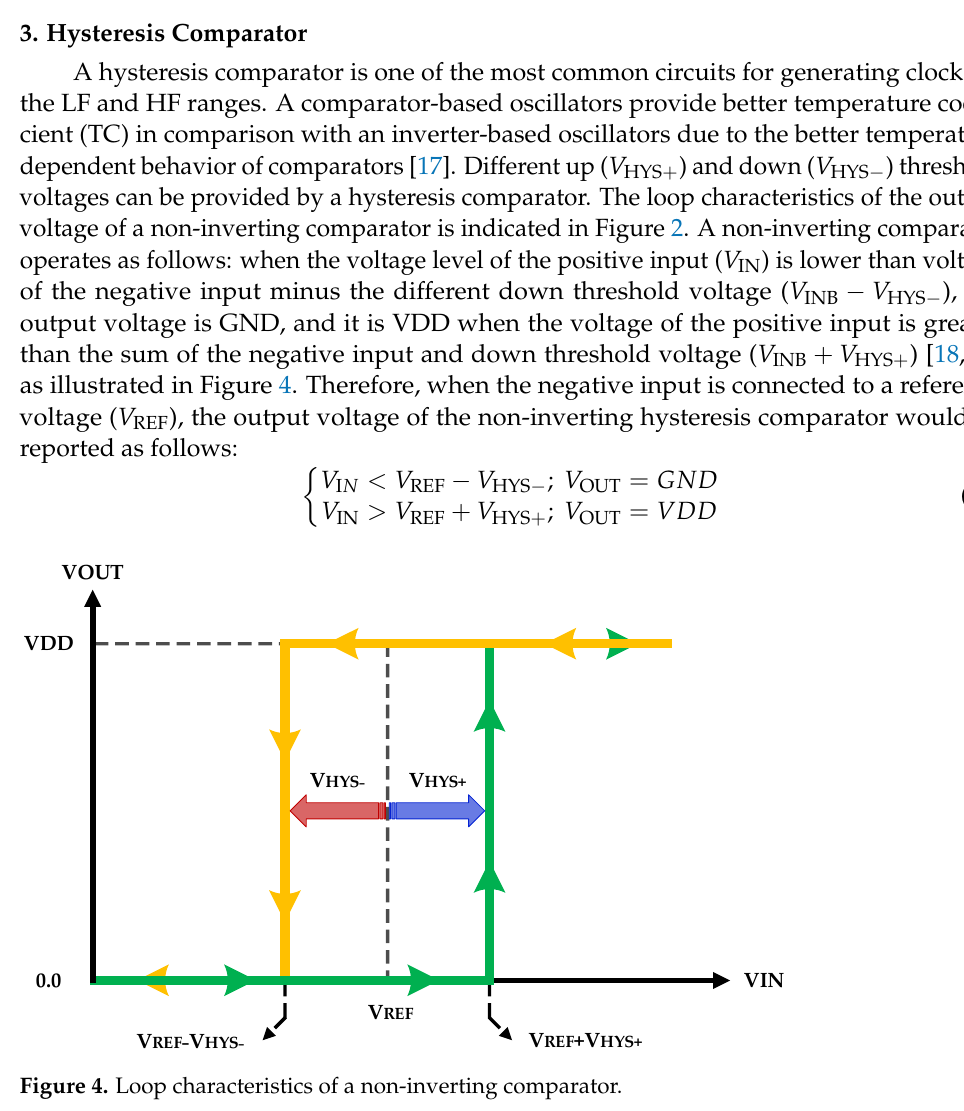
Figure 3. Timing diagram of the positive input (Node.1) and output of Comp.2.